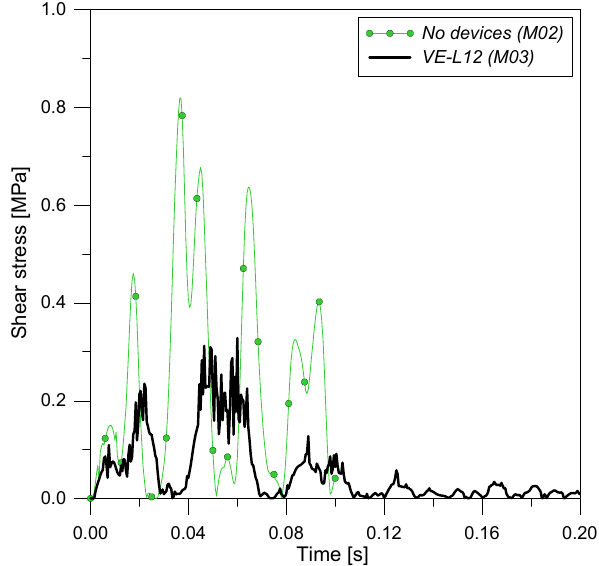
Figure 21. Comparison of maximum envelope of shear stress in the bead of